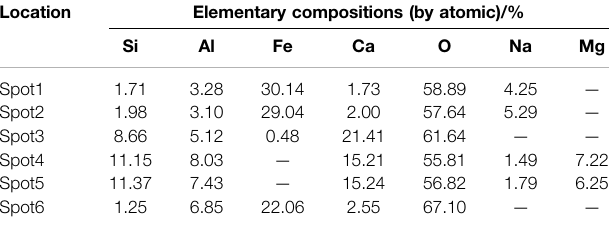
TABLE 5 | Elementary compositions of detection